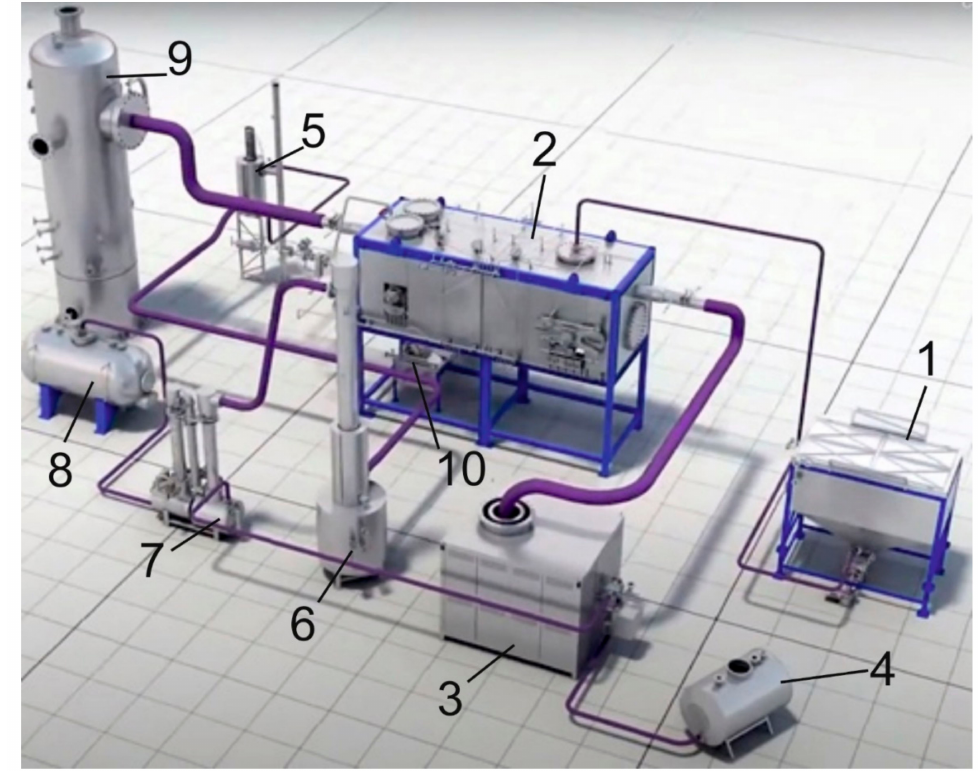
Figure 2. Setup for steam pyrolysis of OS: 1—loading unit, 2—reactor, 3—steam boiler, 4—fuel storage tank, 5—emergency combustion system, 6—stage I of steam–gas product condensation, 7—stage II of steam–gas product condensation, 8—accumulator of condensed products (water), 9—scrubber, 10—discharging loader for solid-phase